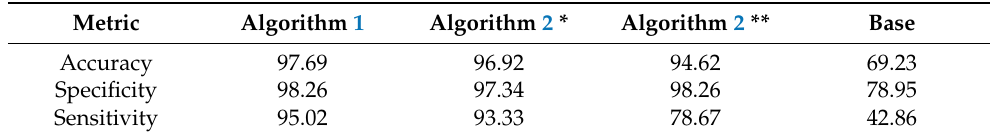
Table 1. Metrics comparing the results of the